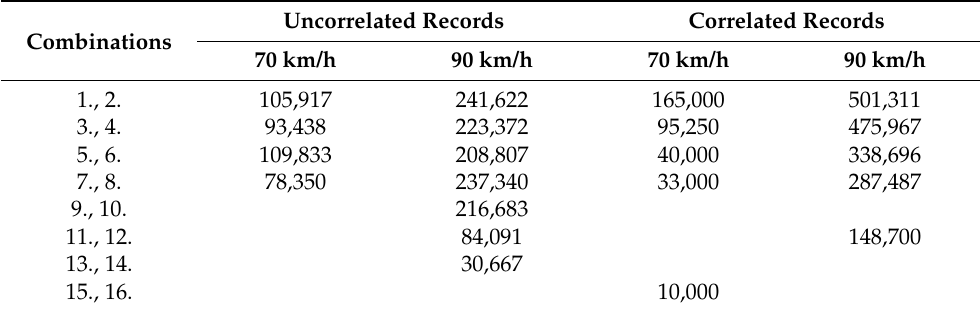
Table 7. Intercomparison of the average society-wide loss due to defect—Short turned down end of the crash barrier.